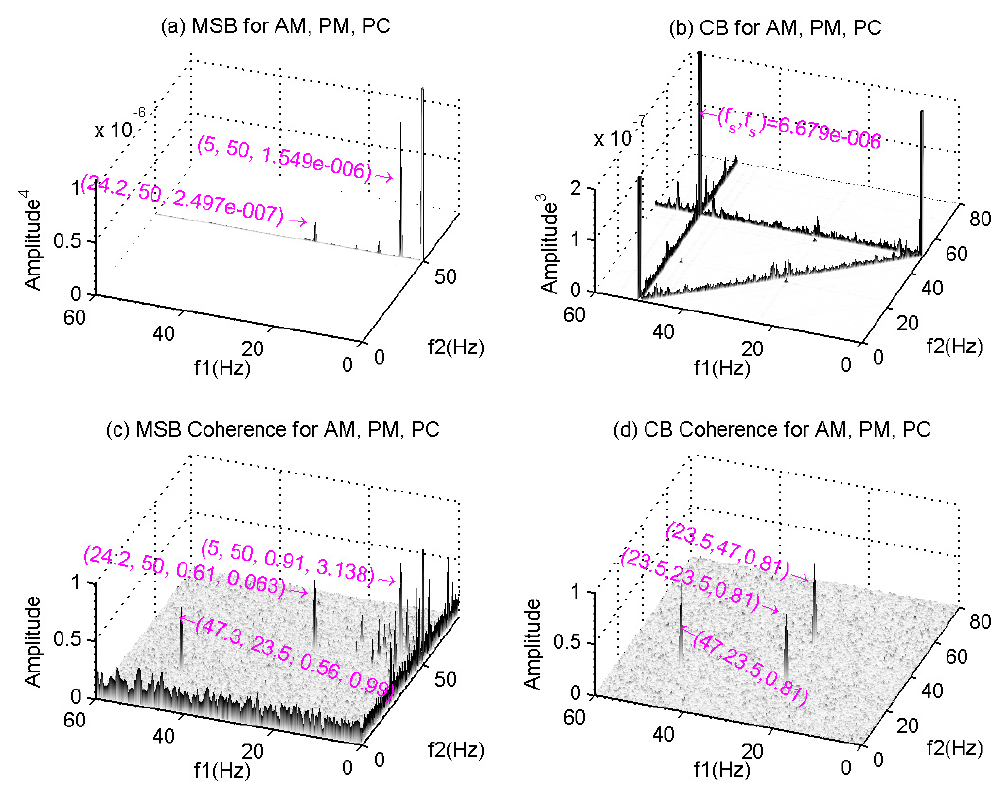
Figure 2. MSB and CB of simulated signal.